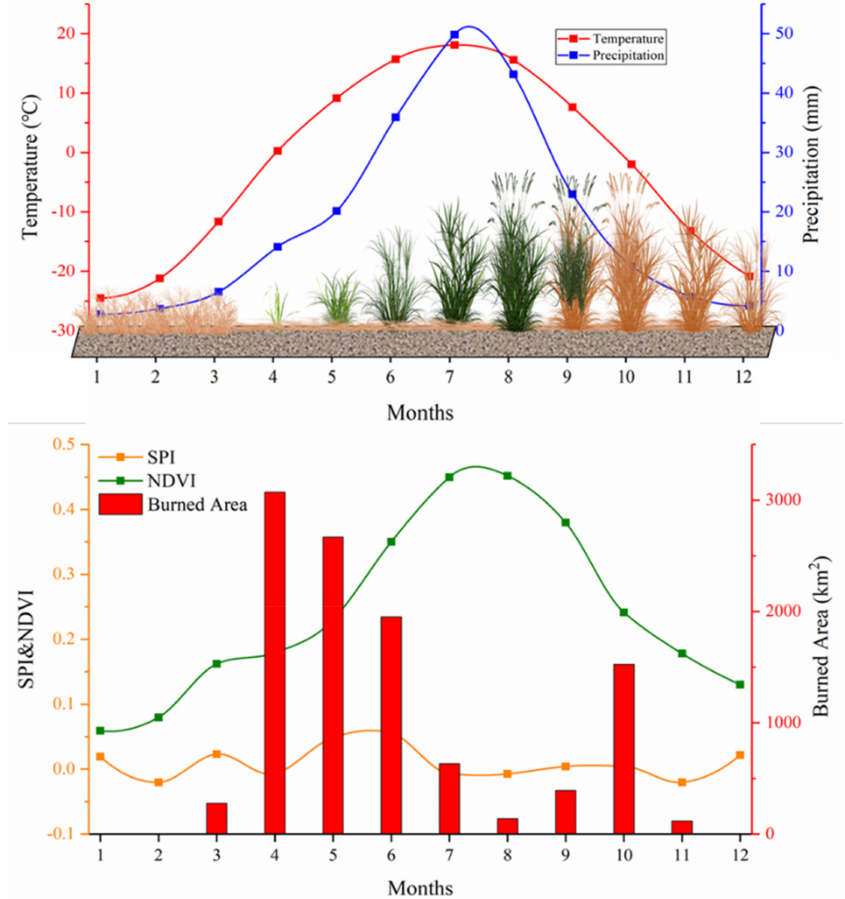
Figure 7. Vegetation phenology drives the intra-annual pattern of wildfire in the Mongolian Plateau